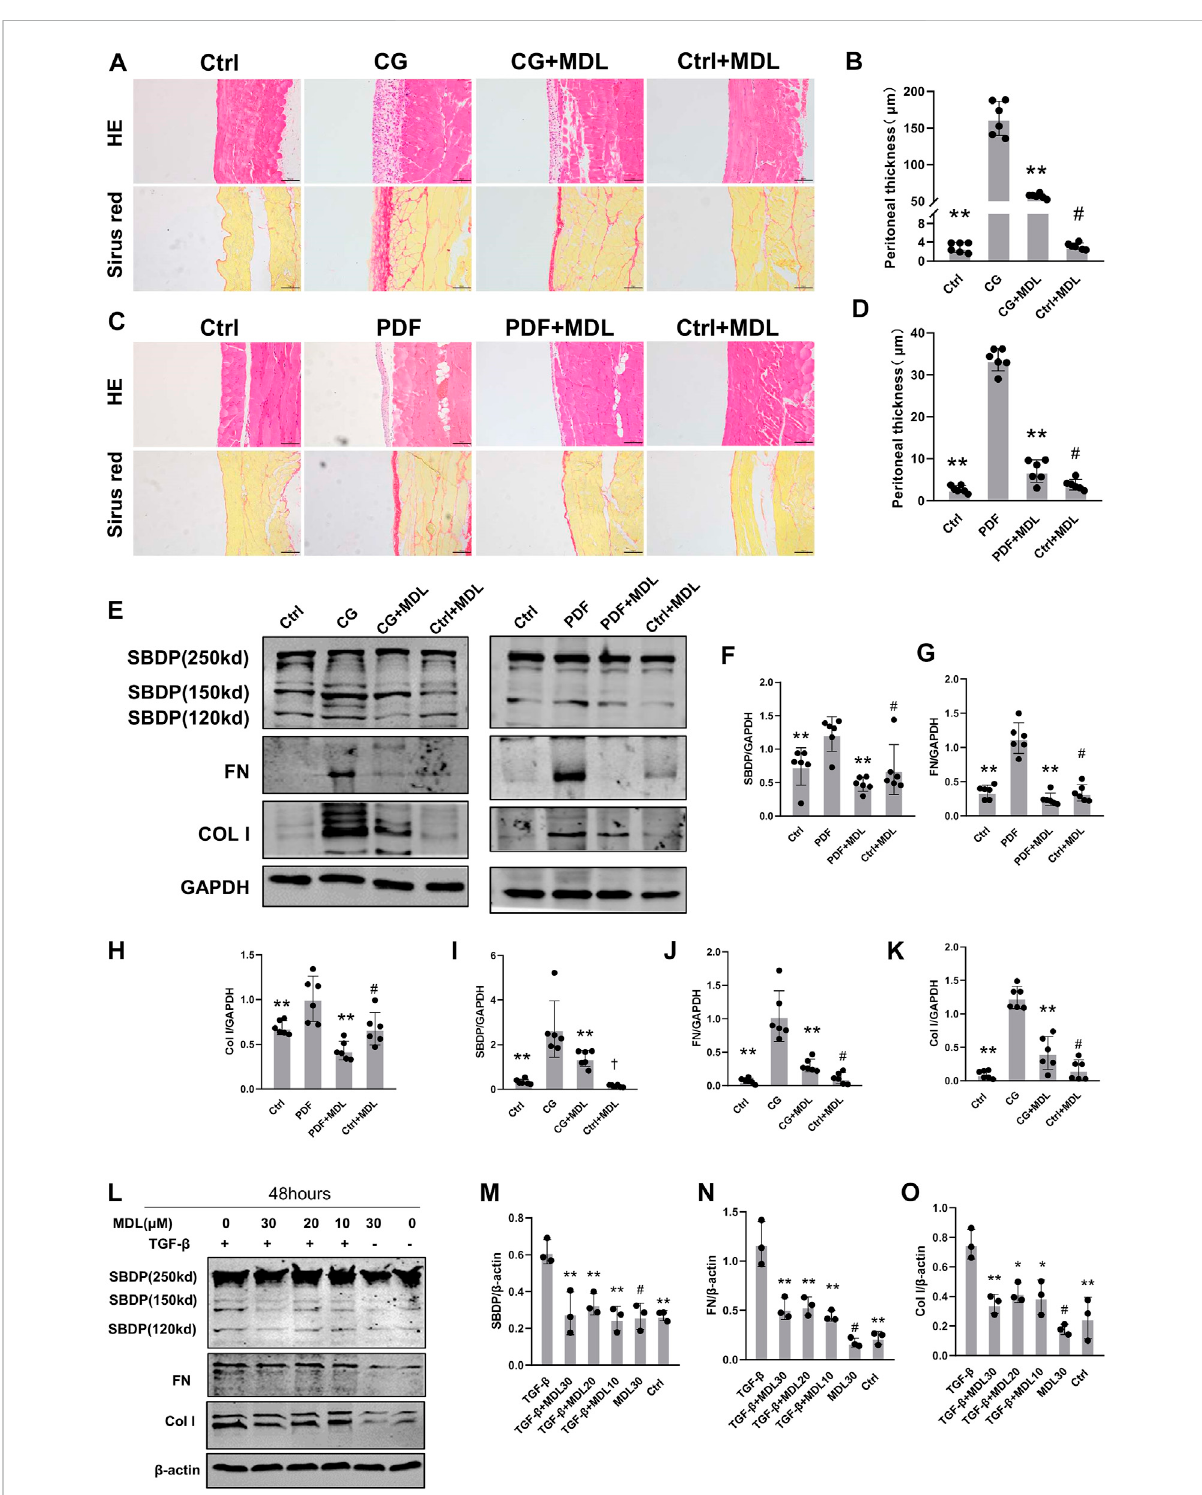
Inhibitionofcalpainactivitycanpreventtheoccurrenceandprogressionofperitoneal fi brosis. (A,B) Peritonealcollection21 daysafterCGinjury after receiving or not receiving MDL (MDL28170) treatment (100 mg/kg/d). The HE and Sirius red staining of the peritoneal were observed by microscope, and the thickness of the dense area was measured (magni fi cation, × 200, scale 100 μ m). (C,D) Peritoneal collection 6 weeks after receiving or not receiving MDL (MDL28170) (100 mg/kg/d), 4.25% PDF intraperitoneal infusion. Values are the mean ± s. e.m. n = 6, * p <